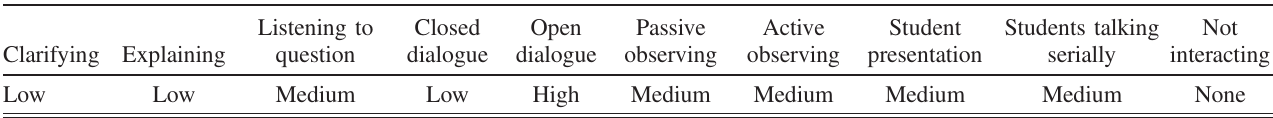
TABLE III. The profile of an ideal TA based on the design of the curriculum as agreed upon by the authors. Clarifying